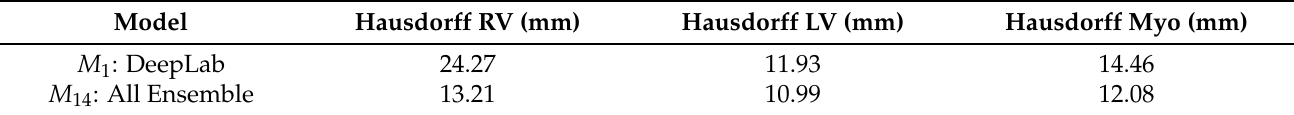
Table 5. Results on the ACDC test set—Hausdorff Distance (RV—right ventricle, LV—left ventricle, Myo—myocardium). Model Hausdorff RV (mm) Hausdorff LV (mm) Hausdorff Myo